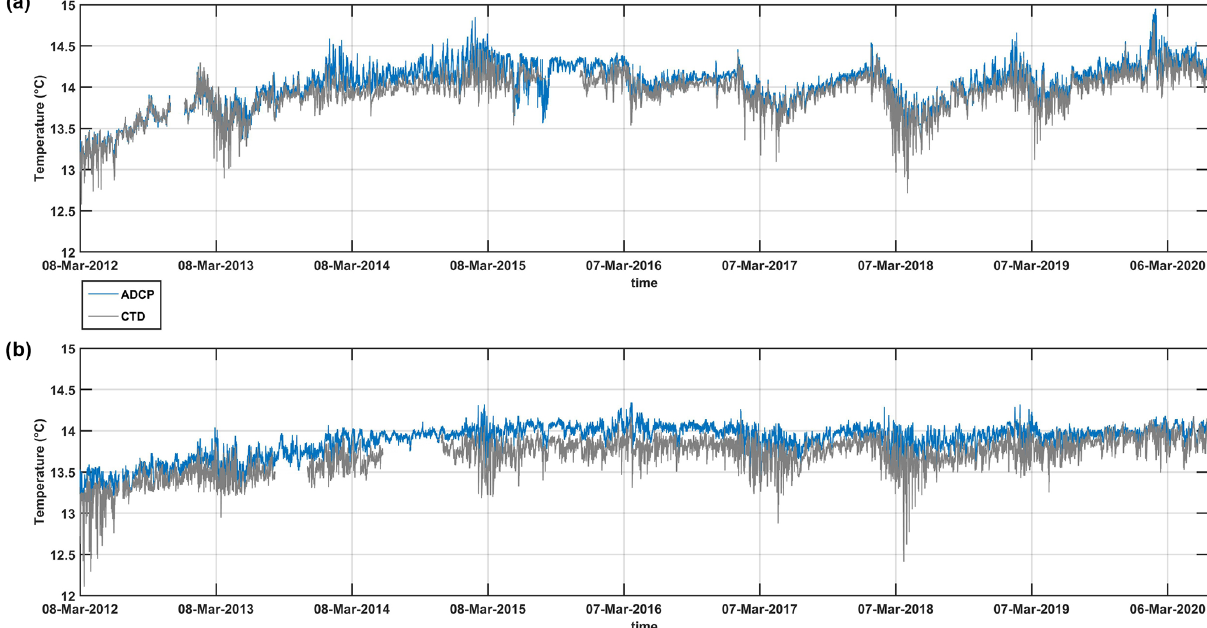
Figure 4. ADCP and CTD temperature records at two mooring sites, (a) BB on canyon (600m depth) and (b) FF on the open slope (700m).